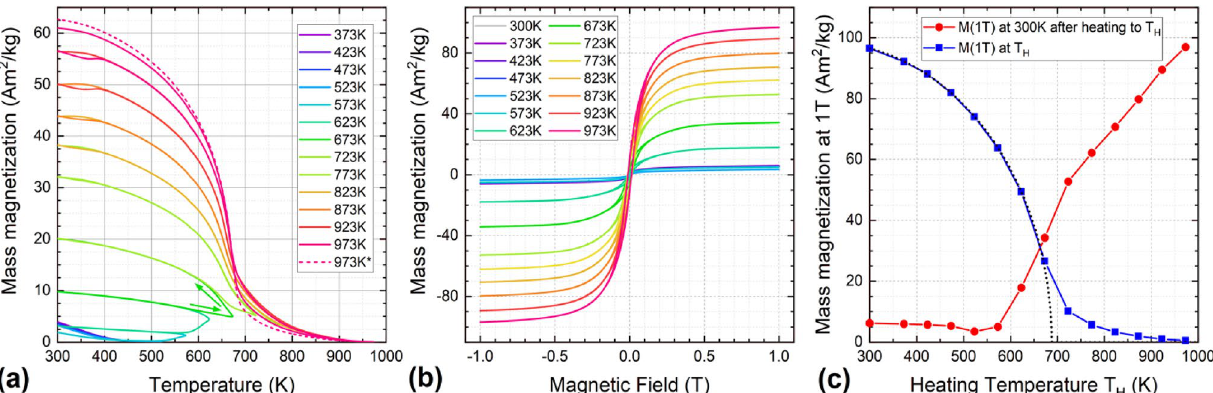
Figure 2. ( a ) Subsequent M(T)-curves were recorded at 0.1 T with increasing annealing temperature T H ; the last temperature cycle was measured twice (dashed) to check reproducibility ( b ) M(H)-curves of FeRh nanoparticles recorded at 300 K after annealing at different temperatures T H , ( c ) magnetization values measured at 1 T as a function of T H (blue, see Fig. S2) interpolated via the Brillouin function (dotted, for details see text) and measured at 300 K after each annealing step (red, from ( b Fig. 2a, the first indications of the reversible thermal hysteresis assigned to the AFM-FM transition characteristic for B2-FeRh are present, starting at app. T H ≈ 773 K, and increasing in intensity up to the maximum annealing temperature. An additional curve at 973 K (dashed line) was measured to check the reproducibility, repeating the annealing to 973 K and cooling to 300 K. M(T)-curves corresponding to the highest values of T H also show a decrease in magnetization above the Curie temperature of FeRh, which is typically approximately 675 K 63 . This could originate from the decomposition of a minor oxide contribution present in the original sample material with a higher ordering temperature. To compare the effect of a higher magnetic field, 1 T-M(H) curves were also recorded at the respective annealing temperatures T H to characterize the temperature-dependent high-field magnetization (Fig. S2). The results are shown in Fig. 2 (c, blue), allowing us to estimate the Curie temperature to be ca. 680 K by reproducing the data points via the Brillouin function. Additionally, a zero-field cooled – field cooled (ZFC–FC) magnetization measurement spanning the entire relevant temperature range from 5 to 773 K can be found in Fig. S3.